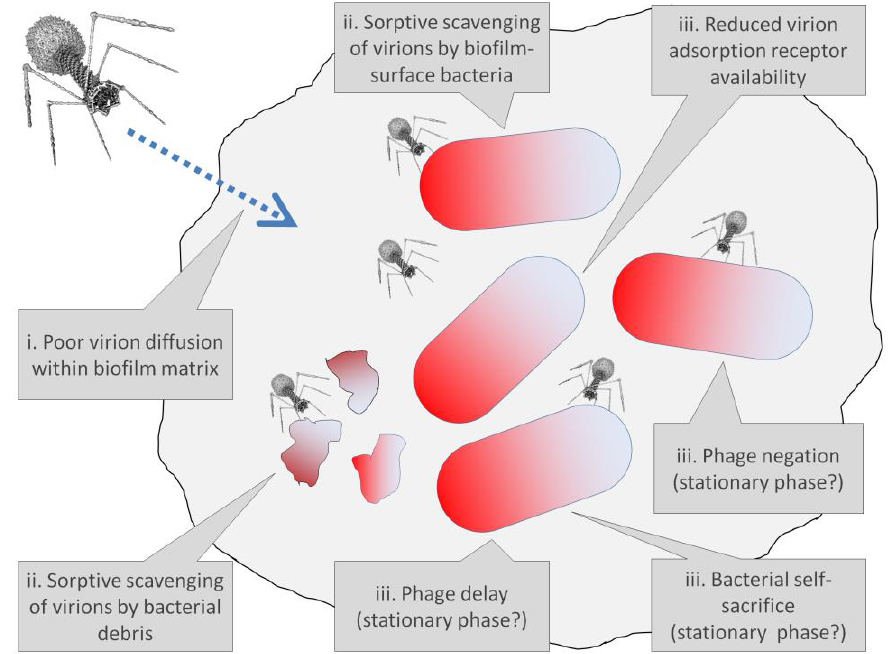
Figure 5. Various potential mechanisms within bacterial biofilms of tolerance of phages. Biofilm matrix is represented as a gray blob encompassing a majority of the figure, while bacteria, not drawn to scale, are represented by shaded bacilli shapes. Note that not all tolerance mechanisms necessarily involve changes in bacterial phenotypes or are associated solely with biofilm existence. For instance, sorptive scavenging, as a tolerance mechanism, is a function at least in part of bacte-